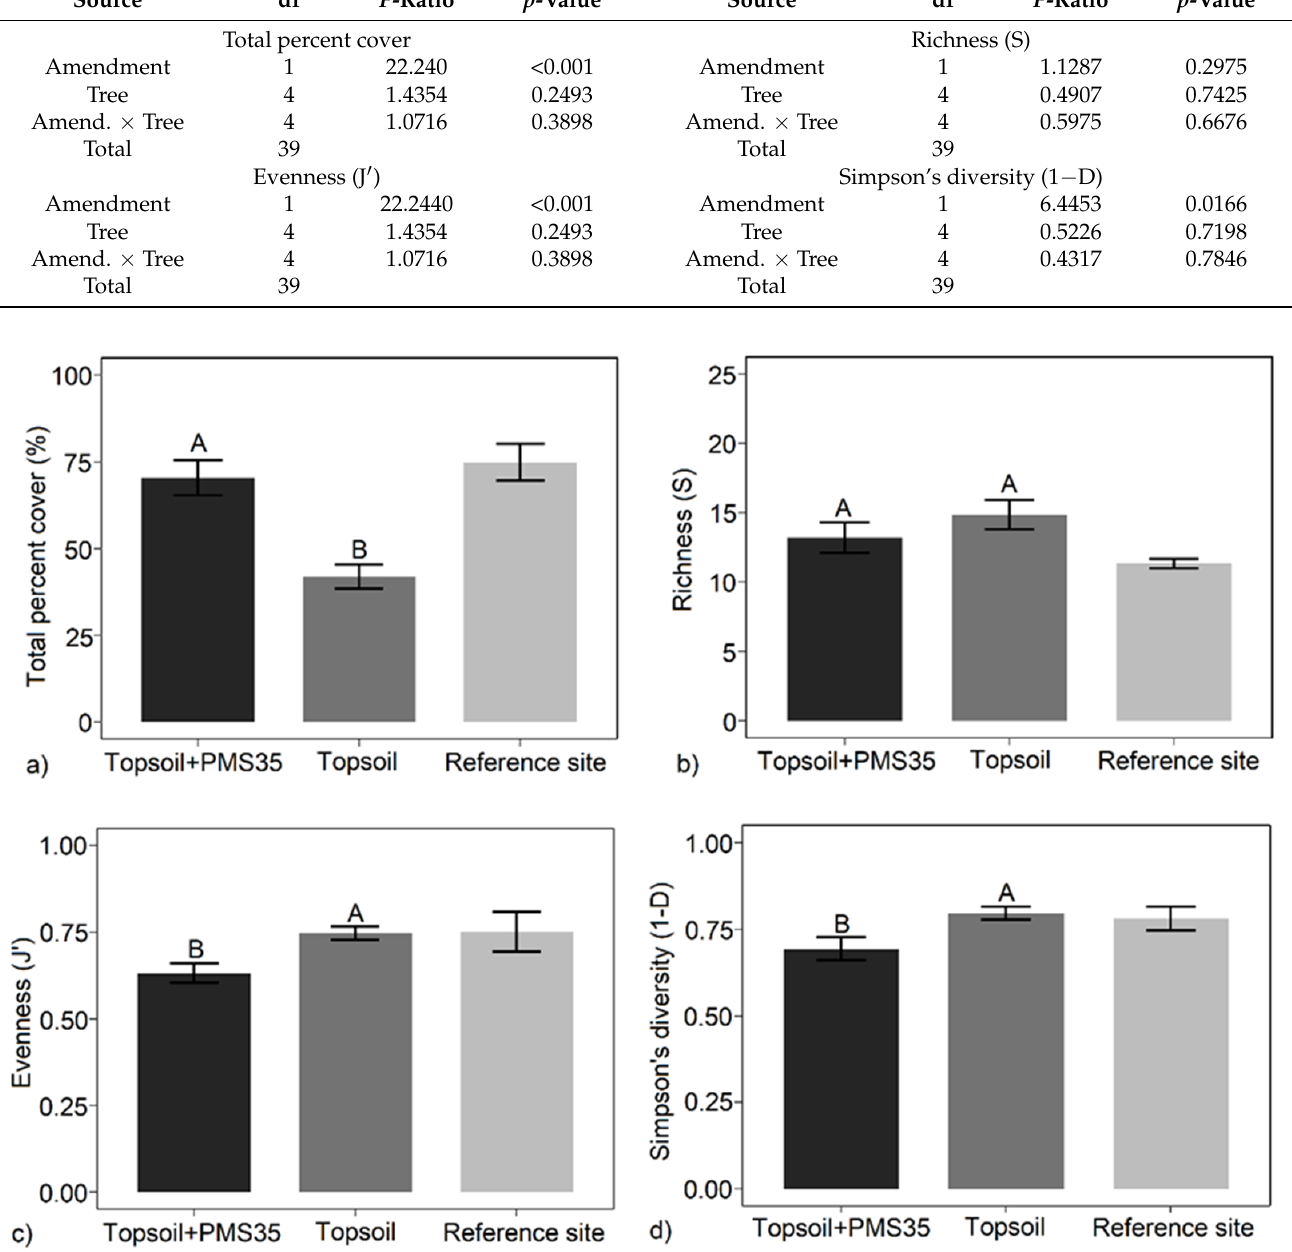
Figure 1. Mean: ( a ) total percent cover; ( b ) richness (S); ( c ) Pielou’s evenness (J’); ( d ) Simpson’s diversity (1 − D) in relation to the amendment applications (topsoil+PMS35 and topsoil) ( ± SE; n = 4) at Niobec and its reference sites. Letters represent statistical differences between treatments following post hoc tests, and brackets on each bar correspond to the standard error (the reference site was not included in the statistical analysis).